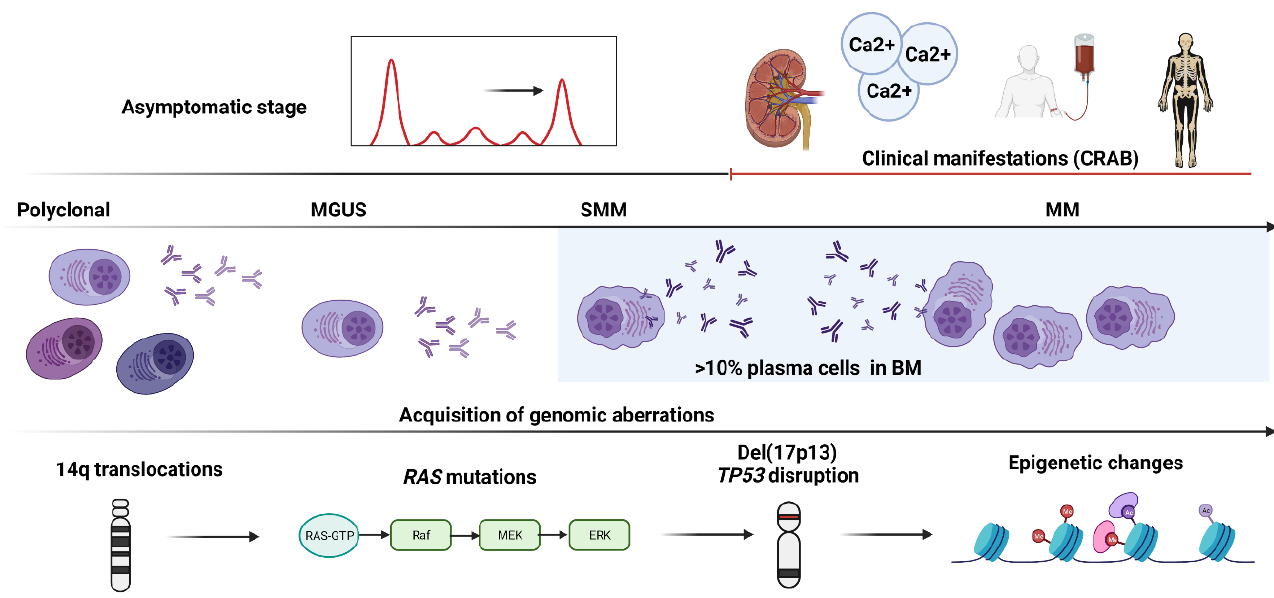
Figure 3. The step-wise acquisition of genomic aberrations in a patient with multiple myeloma. The figure shows a schematic representation of the stepwise acquisition of genetic aberrations in an exemplary patient with multiple myeloma (MM) from the preclinical/asymptomatic stage (monoclonal gammopathy of undetermined significance, MGUS), to smoldering MM (SMM) and later to the clinical/symptomatic stage characterized by typical manifestations of calcium elevation, renal dysfunction, anemia, and bone disease (CRAB).